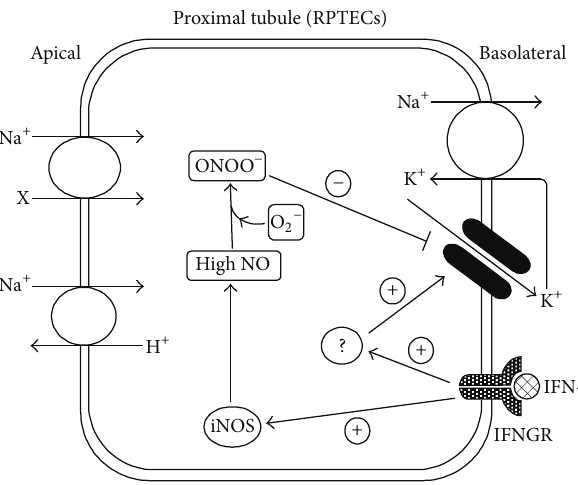
Figure 1: Illustration of the time-dependent biphasic effect of IFN- 𝛾 on the 40 pS K + channel in RPTECs. Prolonged treatment of cells with IFN- 𝛾 greatly enhances iNOS expression, which results in generation of a large amount of NO. The excessive NO reacts with superoxide (O 2− ) to form peroxynitrite (ONOO − ), which impairs the 40 pS K + channel by oxidation and/or nitrosylation. IFN- 𝛾 also acutely activates the 40 pS K + channel by unknown